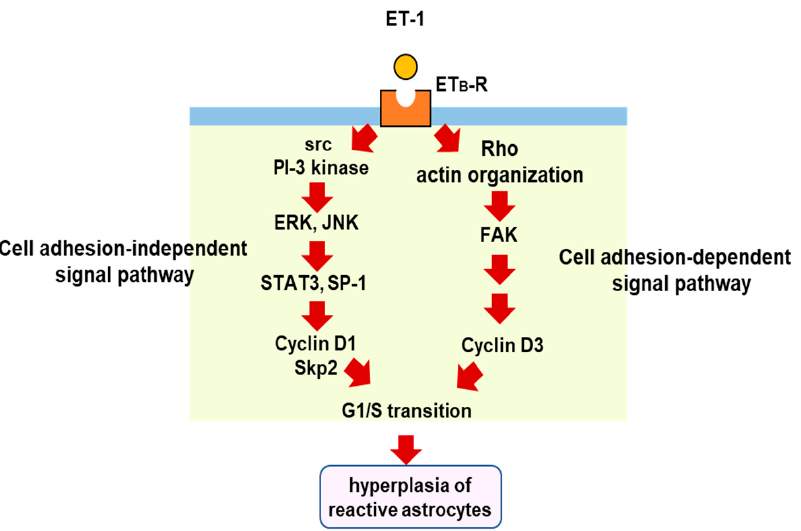
Figure 4. Proliferation signal pathways triggered by astrocytic ET B -R. ET B -R-mediated intracellular signals for astrocytic proliferation include cell adhesion-dependent and -independent pathways. In the cell adhesion-dependent pathway, stimulation of ET B -R causes cytoskeletal actin reorganization through a small G-protein, rho. The formation of focal adhesions accompanied by cytoskeletal reorganization activates FAK and increases cyclinD3 expression. In the cell adhesion-independent signal pathway, stimulation of ET B -R increases the activities of STAT3 and SP-1 through ERK and JNK. These transcription factors increase the expressions of cyclinD1 and S-phase kinase-associated protein 2 (Skp-2). The upregulation of these cell cycle regulatory proteins by ET-1 induces the proliferation of reactive astrocytes in brain disorders, including